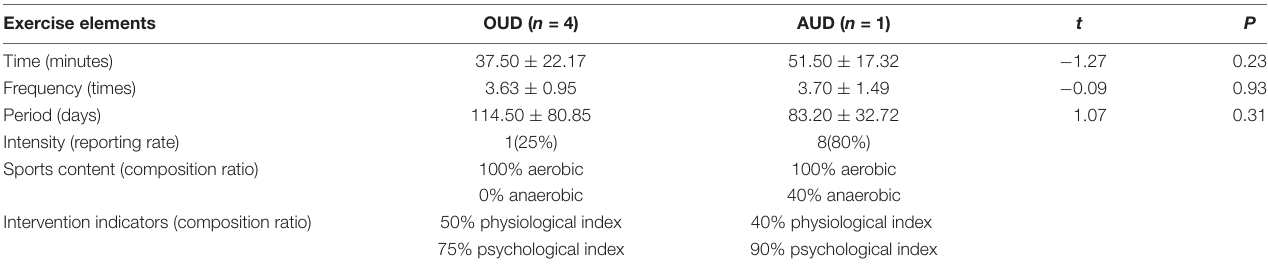
TABLE 4 | Comparative table of exercise intervention programs for people with opioid and amphetamine use disorder, ( ¯ x ± S, n = 12). Exercise elements Time